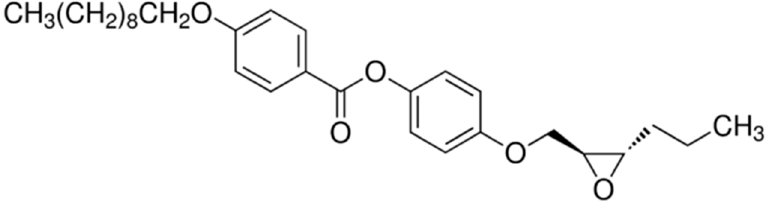
Figure 1. Molecular structure of the EHPDB matrix. The two chiral centers are on the carbons of the epoxy group. Table 1. Mass compositions of Composites 1–6 and Fe 2 O 3 samples with and without oleic acid. Composite Amount of EHPDB Amount of Fe 2 O 3 Amount of Oleic Acid Composite 1 (0.0